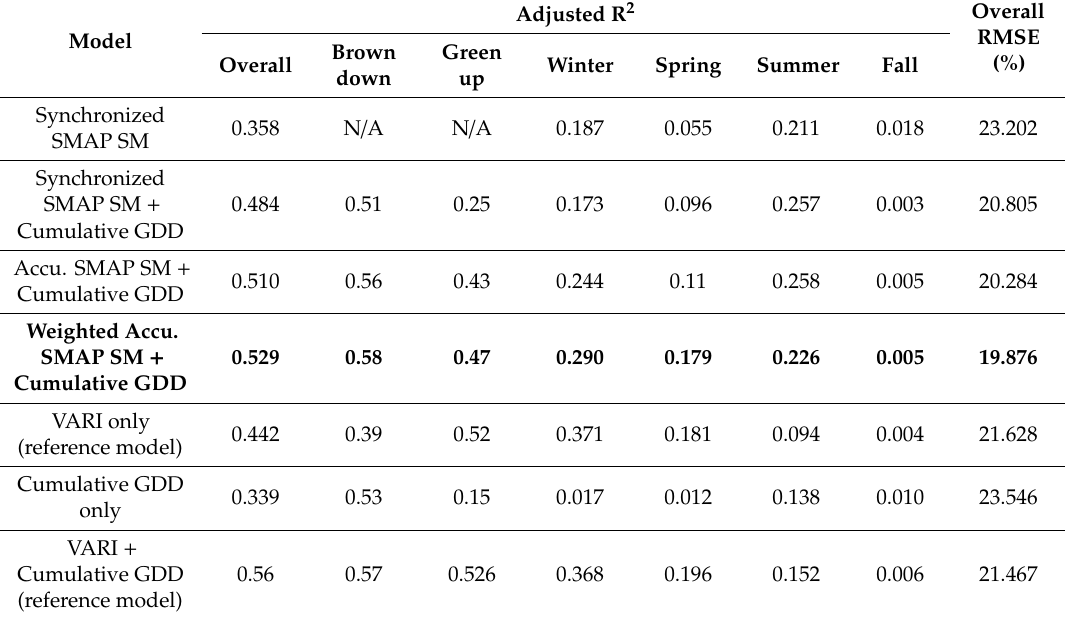
Table 2. Overall, seasonal, and by section model performance of all models discussed. Model with the highest adjusted R 2 using SMAP SM is highlighted in bold text. All models are statistically significant ( p -value <